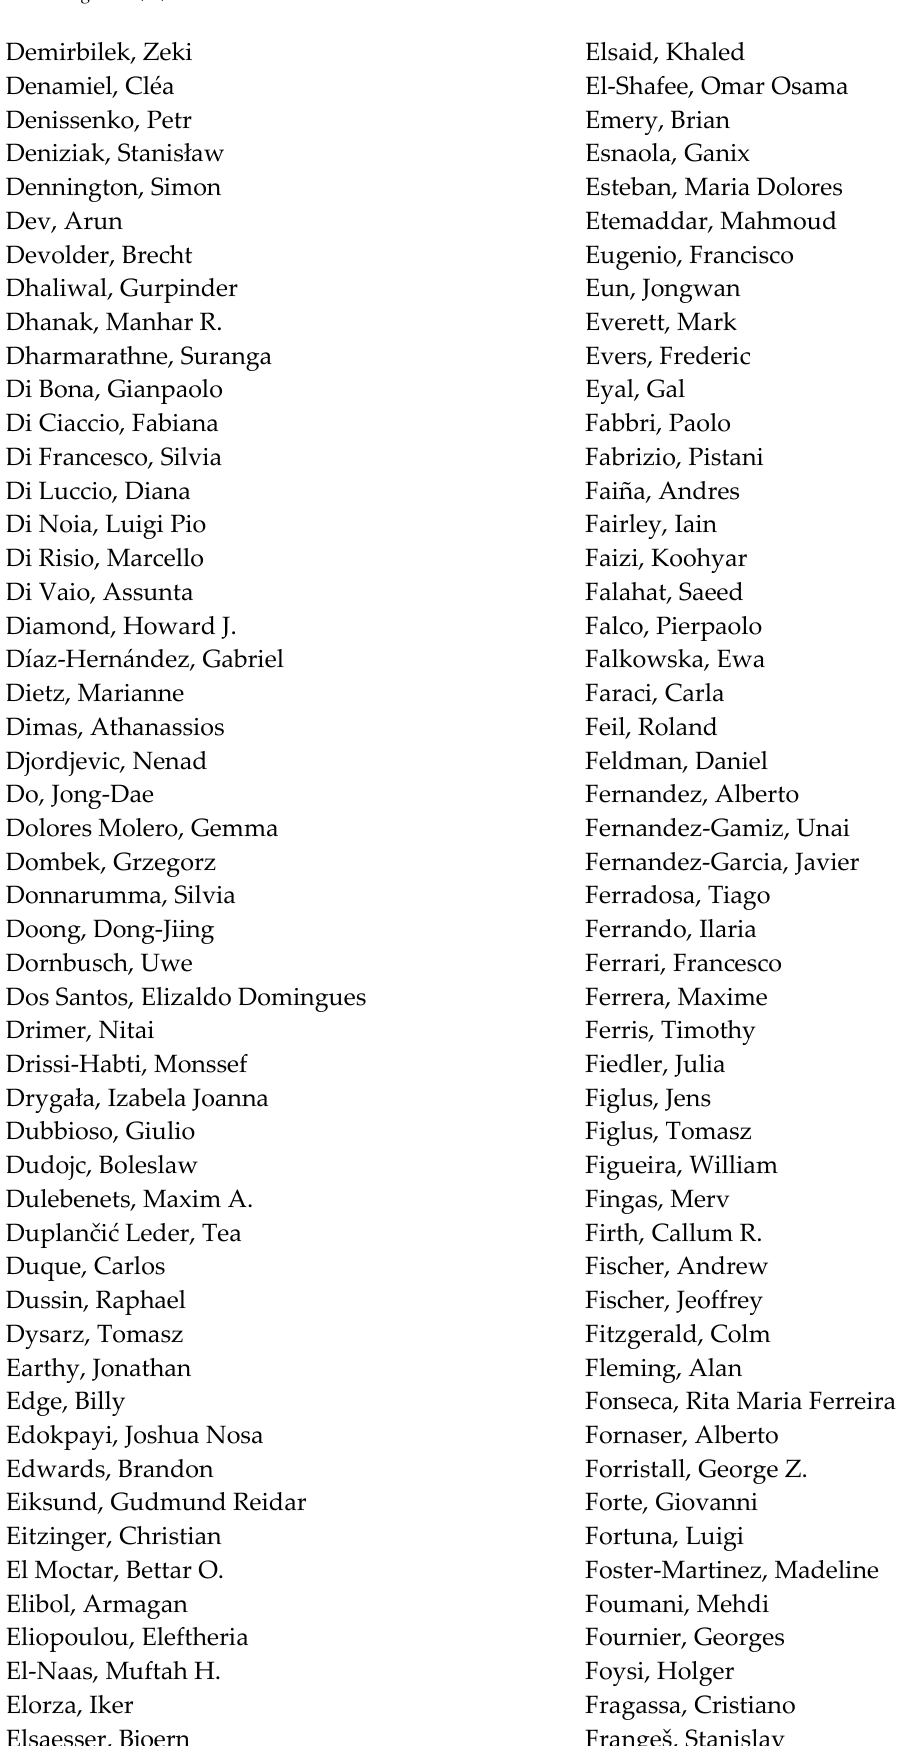
Figlus, Jens Figlus, Tomasz Figueira, William Fingas,